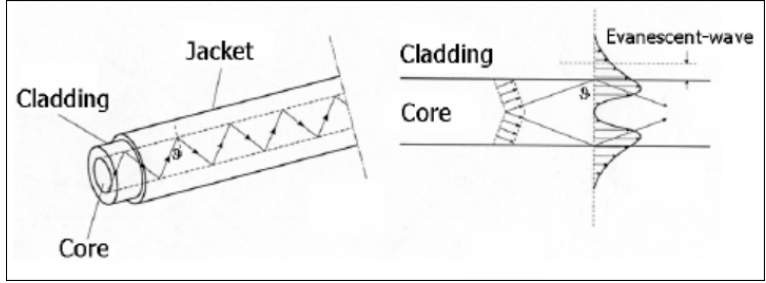
Figure 4. Propagation of light signal in an optical fiber [6].